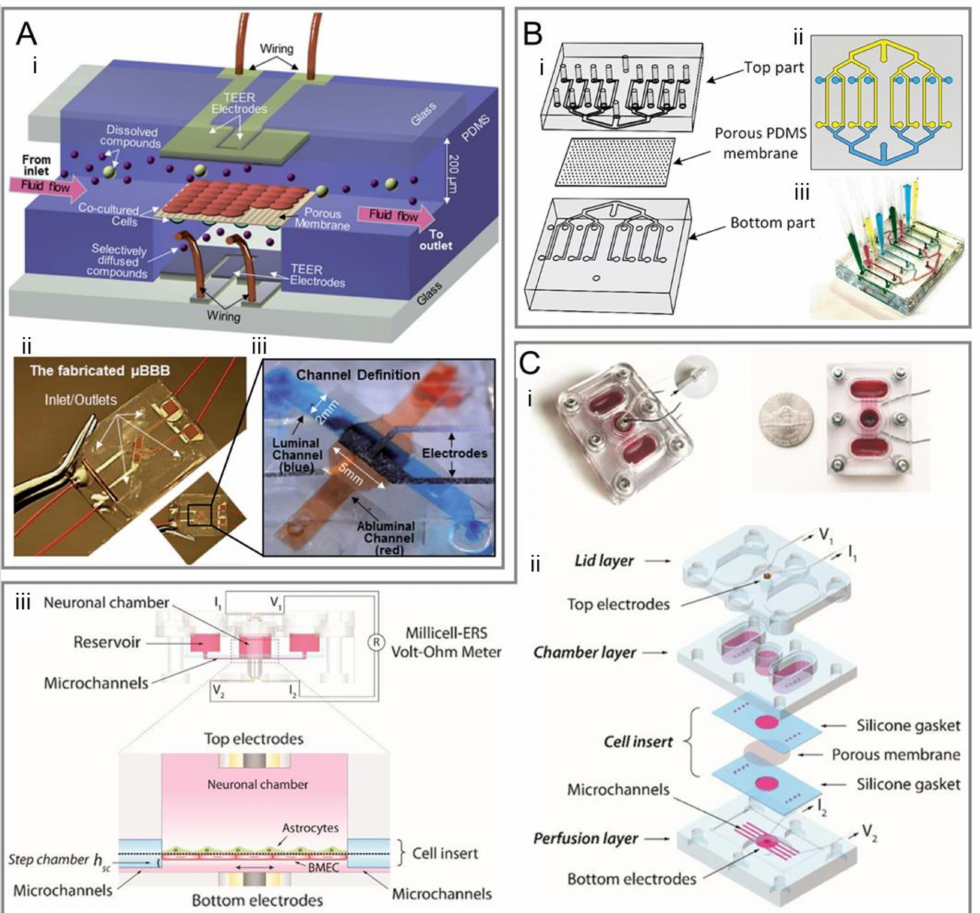
Figure 2. Representative sandwich models of BOCs. ( A-i ) Schematic of a popular sandwich design comprises two perpendicular flow channels and electrodes for TEER measurement. ( A-ii ) The assembled µ BBB chip as shown in panel ( i ). ( A-iii ) An enlarged view of the perpendicular flow channels and electrodes [4]. ( B-i ) Schematic of a multiplexed chip with eight parallel channels separated by a porous PDMS membrane. ( B-ii ) Top view of the two-layer chip design. ( B-iii ) The result of creating eight different conditions in the fabricated two-layer chip [31]. ( C-i ) Fabricated device of a pump-free microfluidic chip. Red dye was used to visualize the microchannels, neuronal compartments, and reservoirs. ( C-ii ) Schematic for the components of the device: a bottom perfusion layer with microchannels and bottom electrodes; a middle chamber layer that forms reservoirs and the neuronal chamber; a top lid layer with top electrodes, which covers the neuronal chamber and the reservoirs to minimize fluid evaporation; a cell insert part made from two silicone sheets and a sandwiched porous polycarbonate membrane. The cell insert part was assembled between the bottom and the middle layers. ( C-iii ) Side view of the device structure, including fluid chamber, microchannels, electrodes connected to a Millicell-ERS Volt-Ohm Meter and the co-cultural orientation of BBB cells